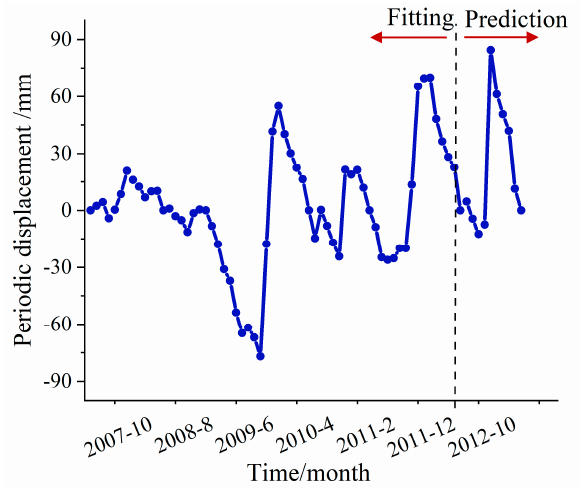
Figure 17. The periodic displacement component of the ZG110 monitoring station was obtained by the differential decomposition